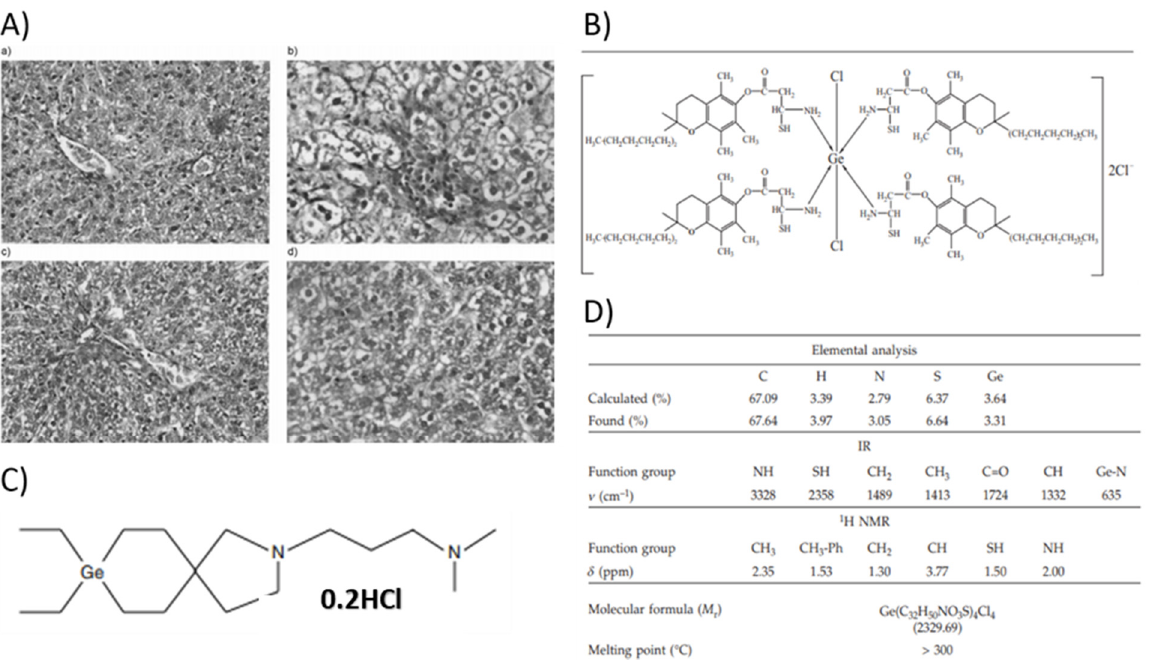
Figure 6. ( A ) ( a ) Normal architecture of control liver of rat; ( b ) the necrosis and fibrosis of liver using inflammatory cells, infiltration of lymphocytes, and proliferation of Kupffer cells; ( c ) the normal shape like the stable hepatic cells is observed due to the treatment of rats with germanium L-cysteine a-tocopherol; ( d ) the marks of improvement in stable architecture are observed due to the treatment of irradiated group with germanium L-cysteine a-tocopherol. ( B ) Chemical structure of germanium, dichloro tetrakis (L-cysteinyl-a-tocopherol amide) dichloride. ( C ) Structure of spirogermanium. Adapted from [97]. Reproduced with permission from Elsevier. ( D ) The EDX results of elemental analysis, NMR, and infrared spectroscopy for the analysis of the presence of functional groups. Adapted from [93]. Reproduced with permission from CPS.